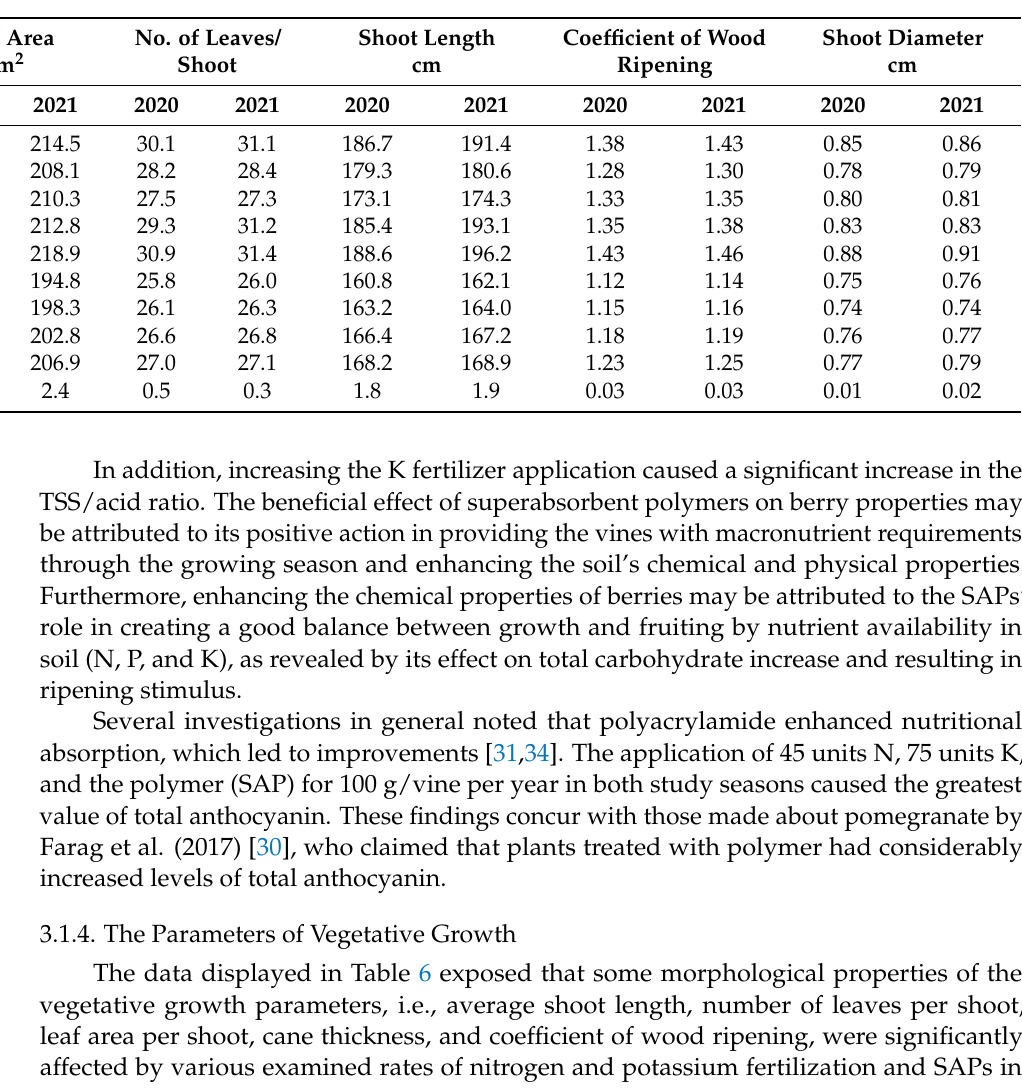
Table 6. Impact of mineral fertilizer individual or mixed with SAPs on vegetative growth parameters of Autumn Royal grapevines in 2020 and 2021